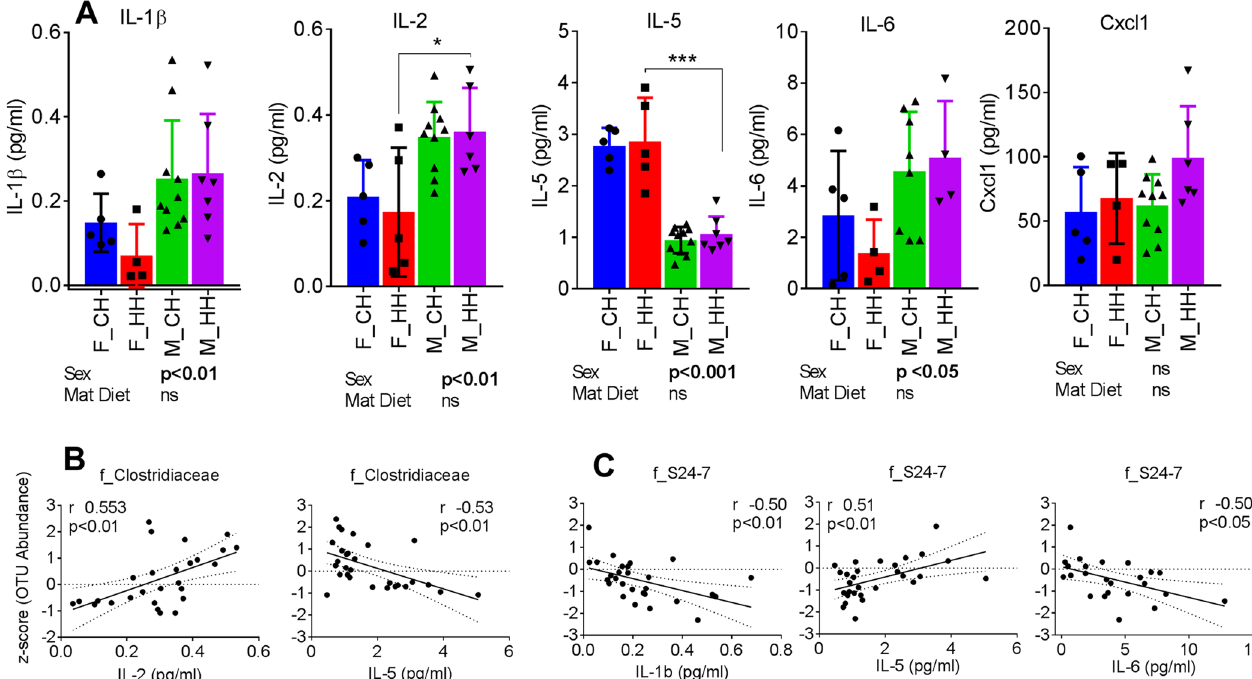
Figure 9. Sexual dimorphism in circulating cytokines and associations with microbial families. ( A ) Serum cytokine levels of IL-1 β , IL-2, IL-5, IL-6 and Cxcl1, and Pearson correlations of cytokines with abundance of ( B ) f_Clostridiaceae and ( C ) f_S24-7. Data are expressed as means ± SD. Statistical differences in gene expression were determined using a 2-way ANOVA to examine the effects of maternal HF and offspring sex, followed by Student-Newman-Keuls post hoc analyses. ( * p < 0.05, ** p < 0.01 *** p <